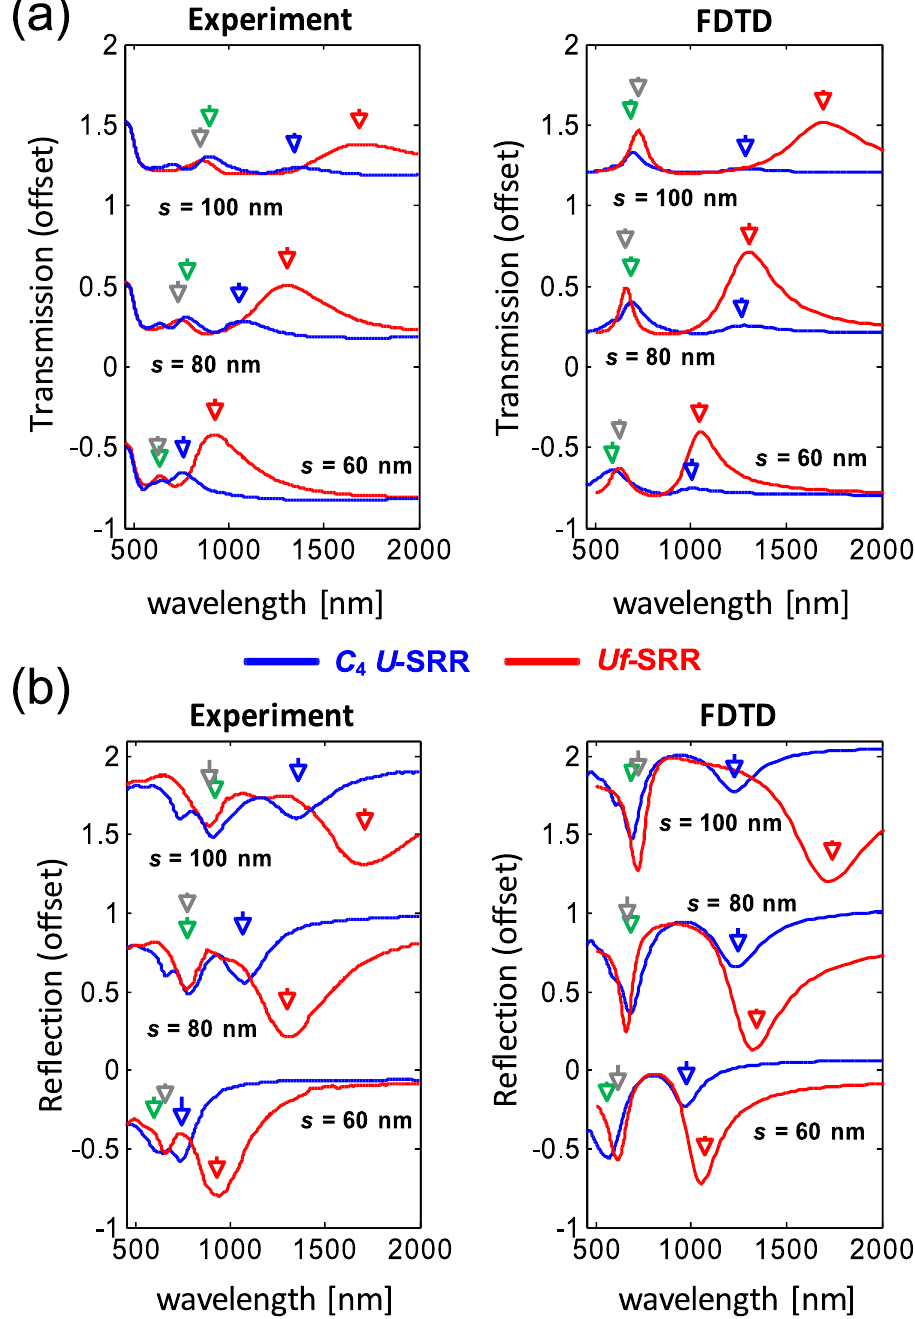
Figure 2. Effect of internal rotational symmetry in improving the optical response under unpolarized light illumination. Transmission ( a ) and reflection ( b ) spectra of the Uf-SRRs (red) and C 4 U-SRRs (blue) for s = 60 nm, 80 nm, and 100 nm, where the measurements and simulations are presented side by side. The arrows denote the modes of the C 4 U-SRRs (green, blue) and the gammadions (red,